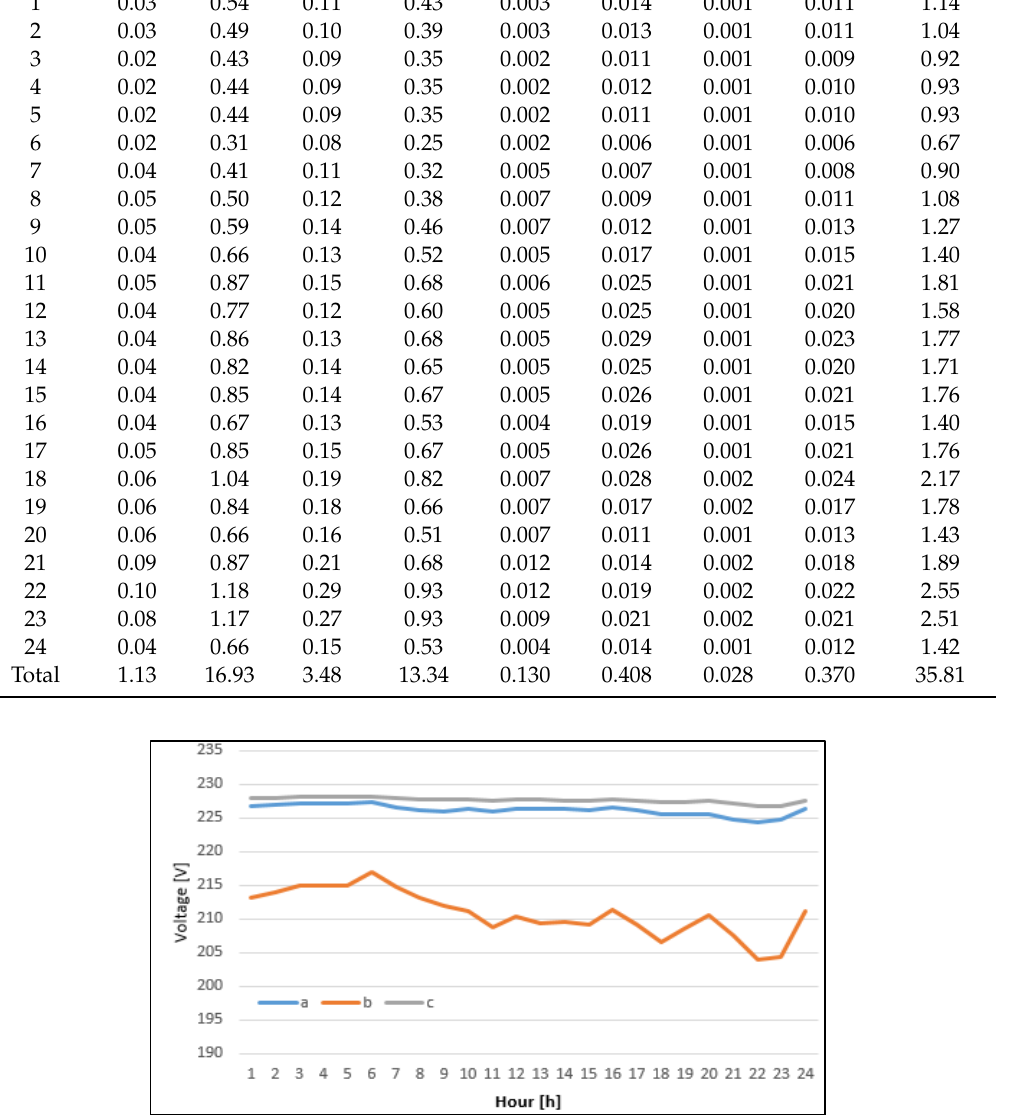
Figure 10. Exemplification of the voltage unbalance at the farthest pillar (P95).